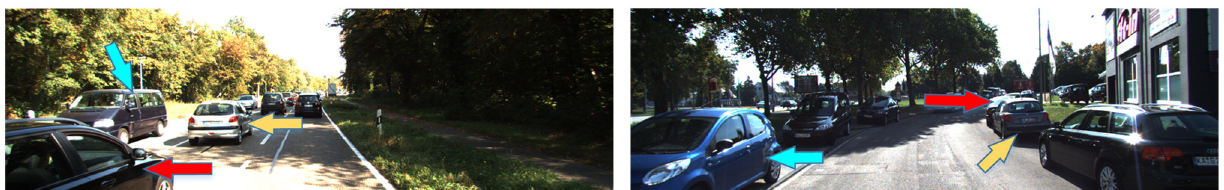
Figure 7. Different difficulty levels of samples. The objects pointed by the yellow arrows belong to the “Easy” difficulty category, which are mostly unoccluded or untruncated, and relatively close to the camera; the objects pointed by the blue arrows belong to the “Moderate” difficulty category, which are slightly occluded or truncated, or slightly farther away from the camera. The objects pointed by the red arrows belong to the “Hard” difficulty category, which are severely occluded or truncated, or far away from the camera.